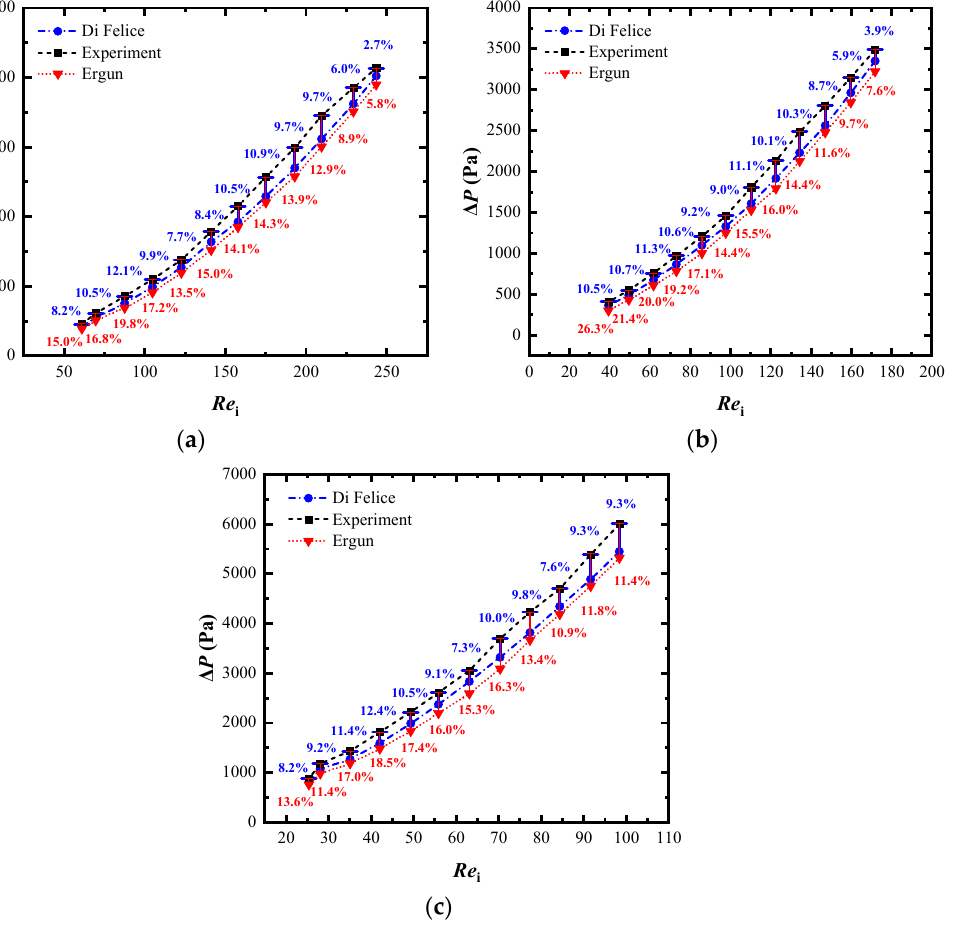
Figure 4. Comparison of pressure drop for three spherical particles: ( a ) 0.005 m in diameter; ( b ) 0.0035 m in diameter; and ( c ) 0.002 m in diameter.